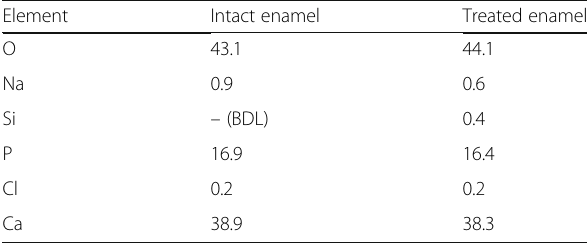
Table 2 Elemental composition (wt%, mean values) of the enamel surfaces for the intact and treated specimens after energy-dispersive X-ray analysis ( n = 5) Element Intact enamel Treated